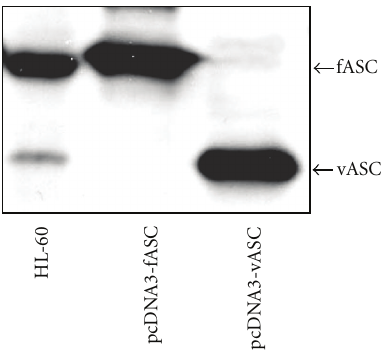
Figure 2: Molecular size comparison of endogenous (HL-60) and exogenous (Cos7) fASC and vASC proteins. Western blotting of endogenous fASC and vASC in HL-60 cells and exogenously expressed products of pcDNA3 fASC and pcDNA3 vASC in Cos7 cells. The band of fASC is 23kDa and that of vASC is